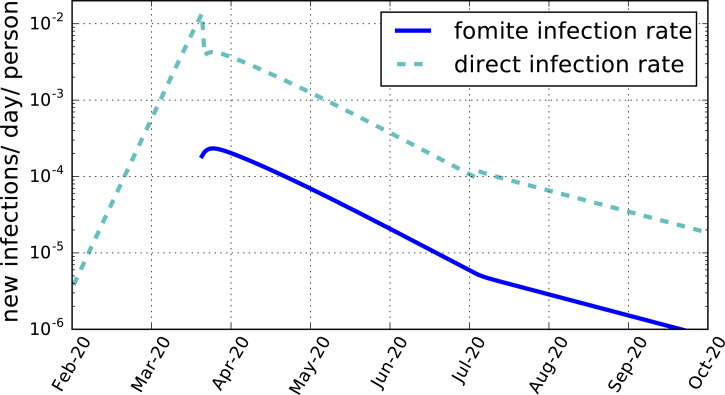
The average daily rate of new infections per susceptible person per day produced by fomites, Tf f/Df (blue solid line), and by direct transmission, Rt i/Di (cyan dashed line), both for the maximum-likelihood model for a mean fomite duration time Df = 0.2 day and Cf = 0.57 day−1 capita−1.